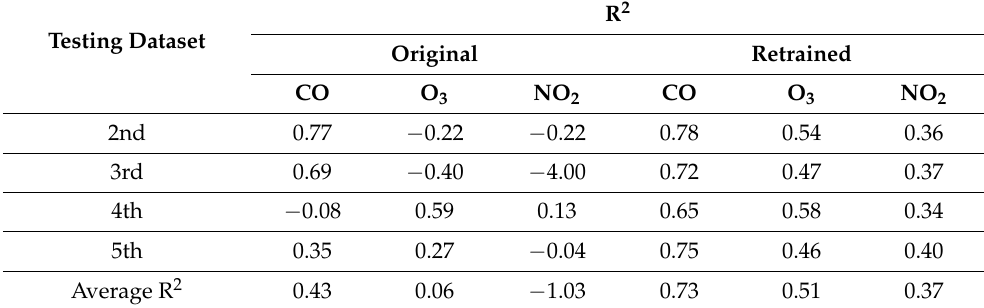
Table 5. Comparison of performance between original model and retrained model.